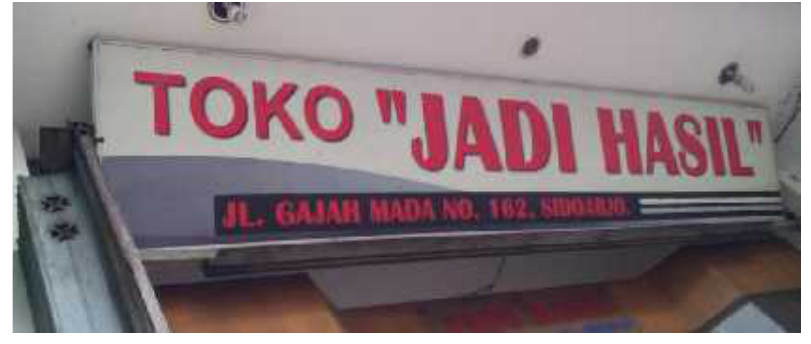
Figure 6. Toko “Jadi Hasil”